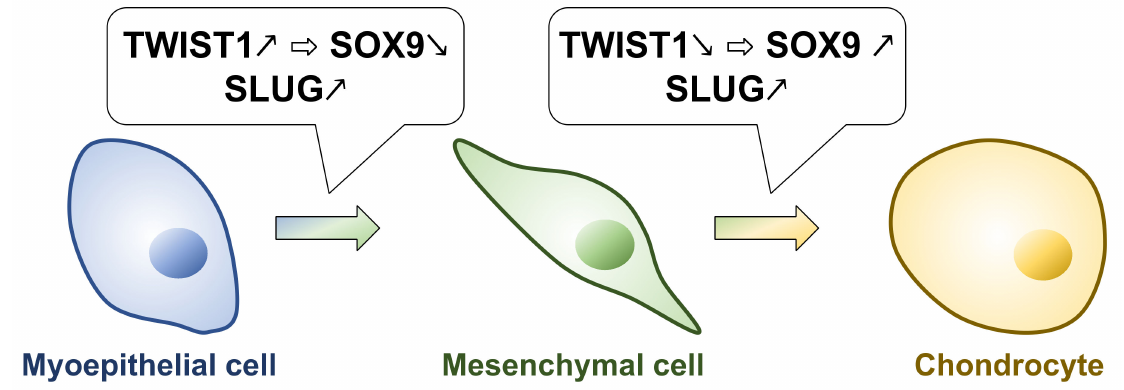
Figure 1. EMT induction and chondrocyte differentiation by changes of TFs expression in